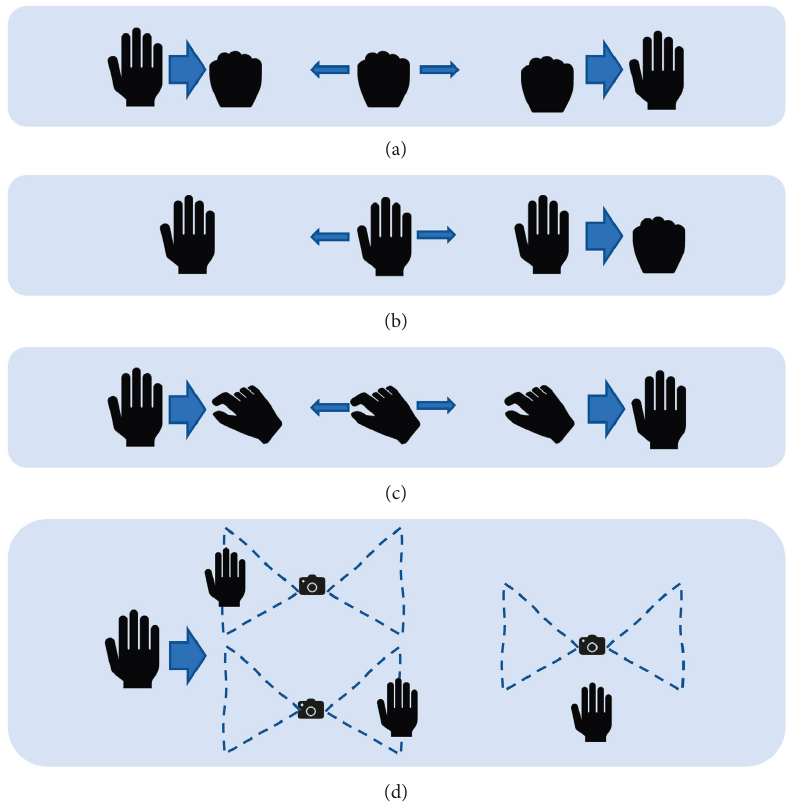
Figure 1: Interaction techniques design: (a) fist, (b) palm, (c) pinch, and (d)